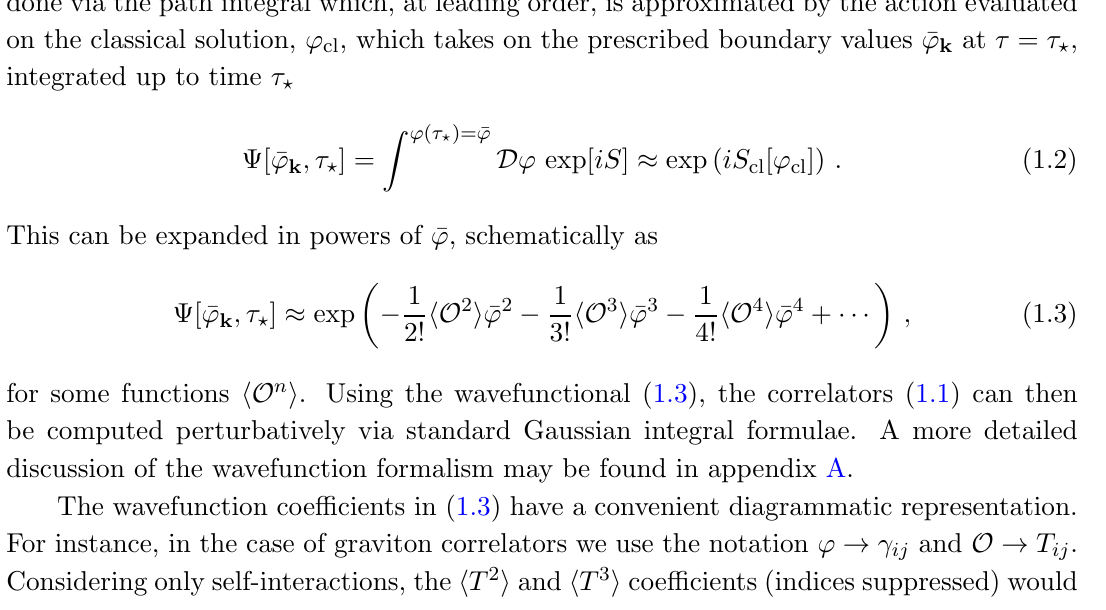
Figure 2 . Diagrammatic expressions for the correlation functions graviton lines correspond to factors of Re to factors of Re different meaning than the wavefunction diagrams of figure 1, despite the similar notation. These instead represent equal-time correlation functions on the time slice τ = τ ⋆